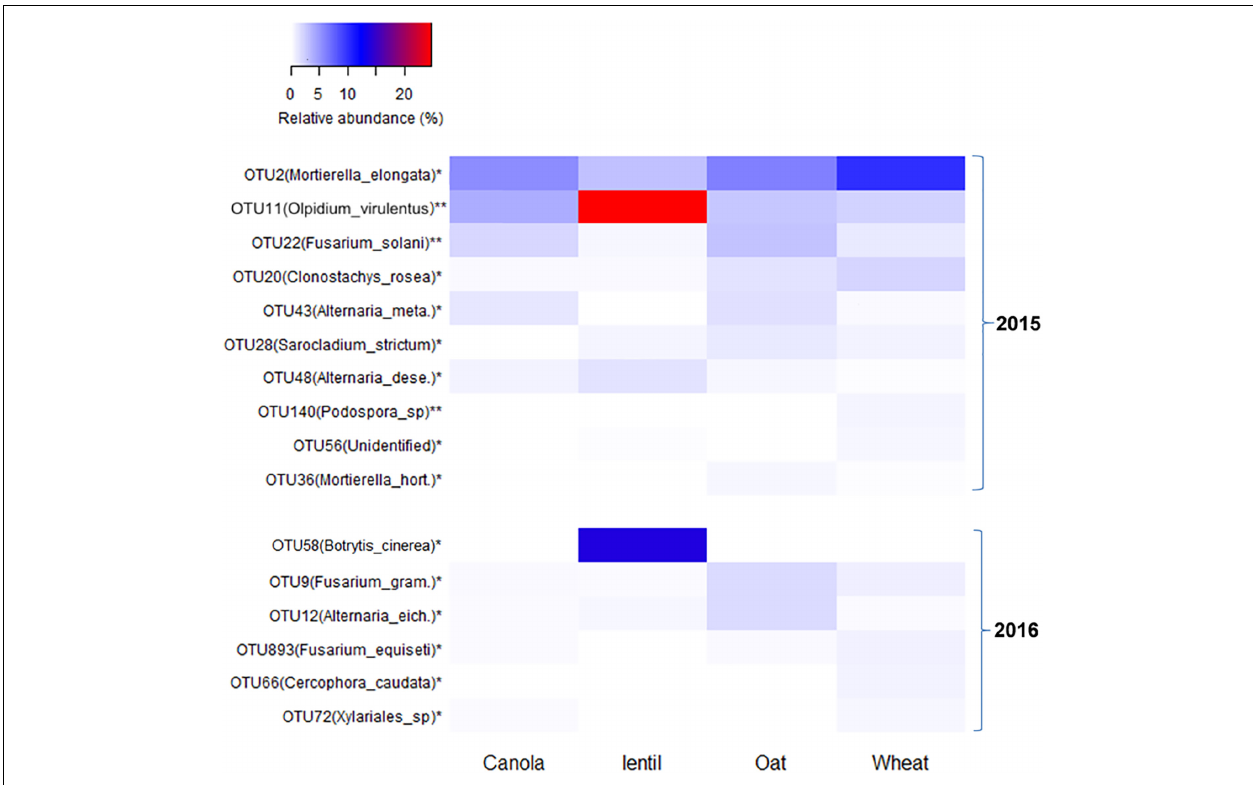
FIGURE 8 | Heatmap showing the most abundant fungal OTUs ( > 0.2% of total reads) in pea rhizosphere that significantly influenced by previous crop in both 2015 and 2016. OTUs with an ∗ indicates a significant difference in relative abundance among previous crops at ∗ P < 0.05 and ∗∗ P < 0.01. Alternaria_meta., Alternaria_metachromatica; Alternaria dese., Alternaria deserticola; Mortierella hort., Mortierella horticola; Fusarium_gram., Fusarium graminearum; and Alternaria_eich., Alternaria_eichhorniae.